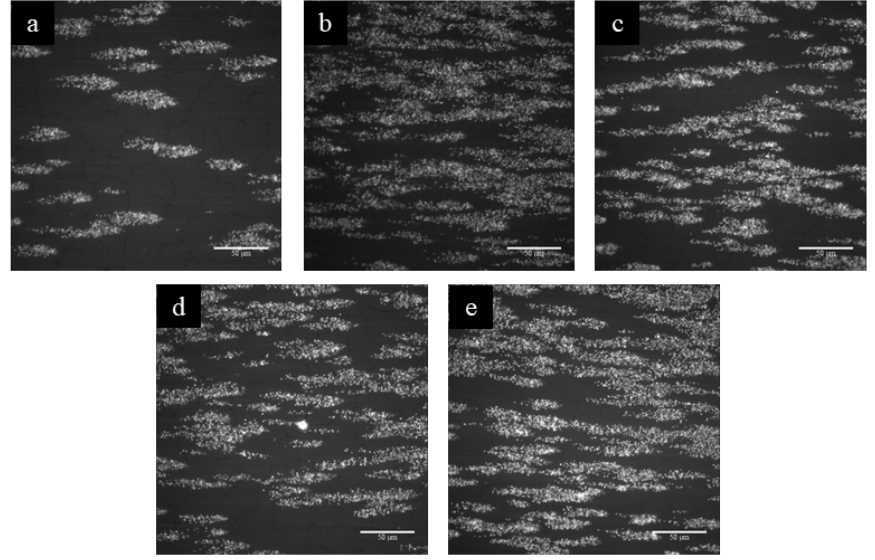
Figure 3. Fluorescence micrographs of DIOC6 labelled whole blood platelets detected in frame 120/120 for 5 replicates ( a – e ) of the air-spun 25PS75PMMA surface (Scale bar = 50 µm).